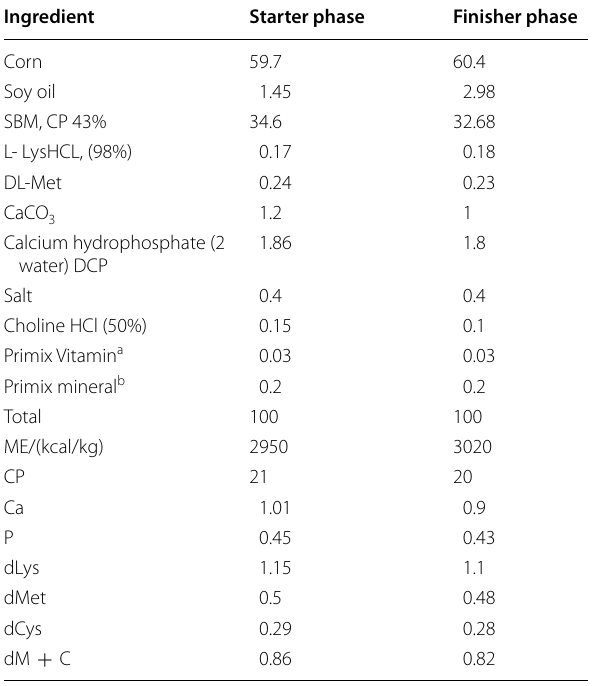
Table 1 Composition and nutrition level of the experimental diets for Yellow-feathered